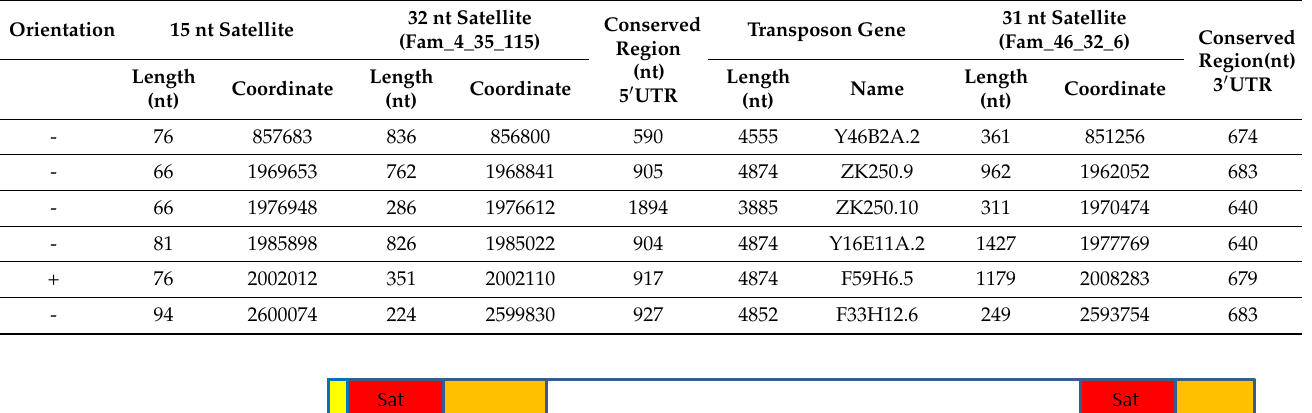
Table 2. Main features of satellites in Fam_46_32_6 and the associated Helitron regions.